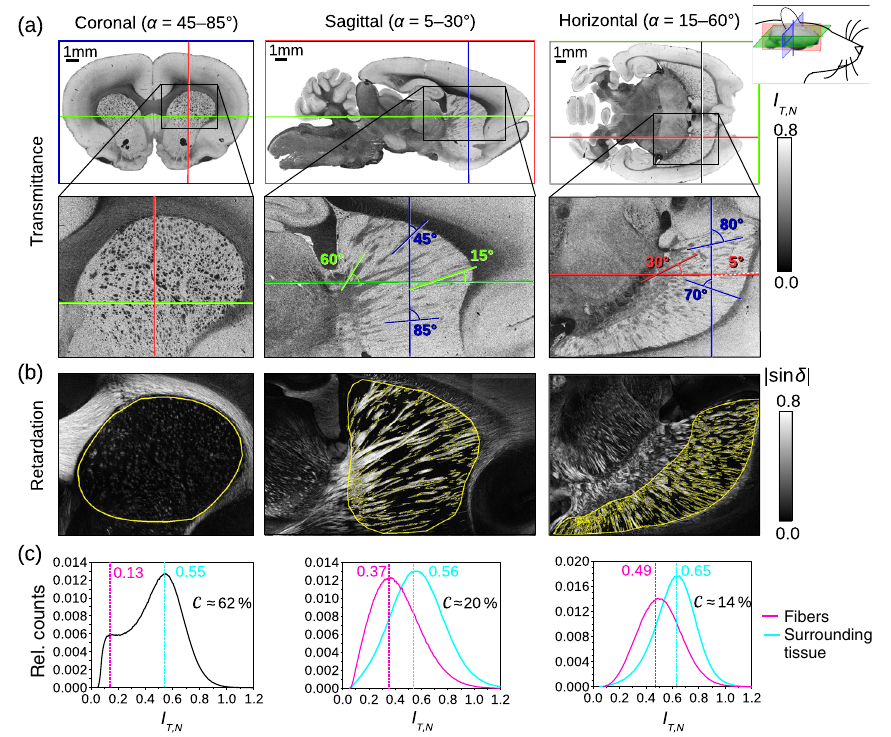
FIG. 14. Transmittance contrast of nerve fiber bundles in mutually orthogonal anatomical planes. (a) Normalized transmittance images ( I ) of a coronal, sagittal, and horizontal rat brain section obtained from 3D-PLI measurements with 1 . 33 μ m pixel size. The colored T;N lines indicate the approximate position of the section planes. The enlarged views show the region of the caudate putamen and the maximum and minimum angles under which the nerve fiber bundles are oriented with respect to the section planes. (b) Corresponding retardation images ( j sin δ j ) of the enlarged views. The image contrast is used to select regions with fibers and with surrounding tissue in the caudate putamen (yellow lines). (c) Histograms of the transmittance values ( I ) for the selected regions with nerve fibers (pink) and T;N with surrounding tissue (cyan) in the caudate putamen. For the coronal brain section, the retardation image cannot be used to separate the fibers from the surrounding tissue, because the fibers are oriented almost perpendicular to the image plane, which leads to a small retardation signal and a small image contrast. Therefore, the histogram is computed over the whole selected region, and the peak with lower (larger) transmittance is assumed to belong to fibers (surrounding tissue). The contrast values are computed from the respective peak values (numbers in pink and cyan) via C ¼ ð max − min Þ = ð max þ min Þ . The contrast for steep nerve fibers (coronal brain section) is much larger than for flat nerve fibers (sagittal and horizontal brain